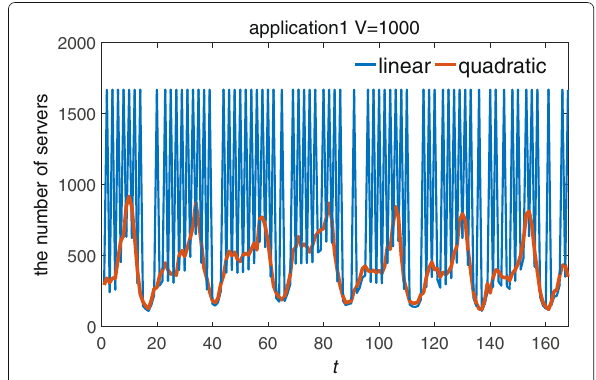
Fig. 12 Servers allocated to user1 with V = 1000